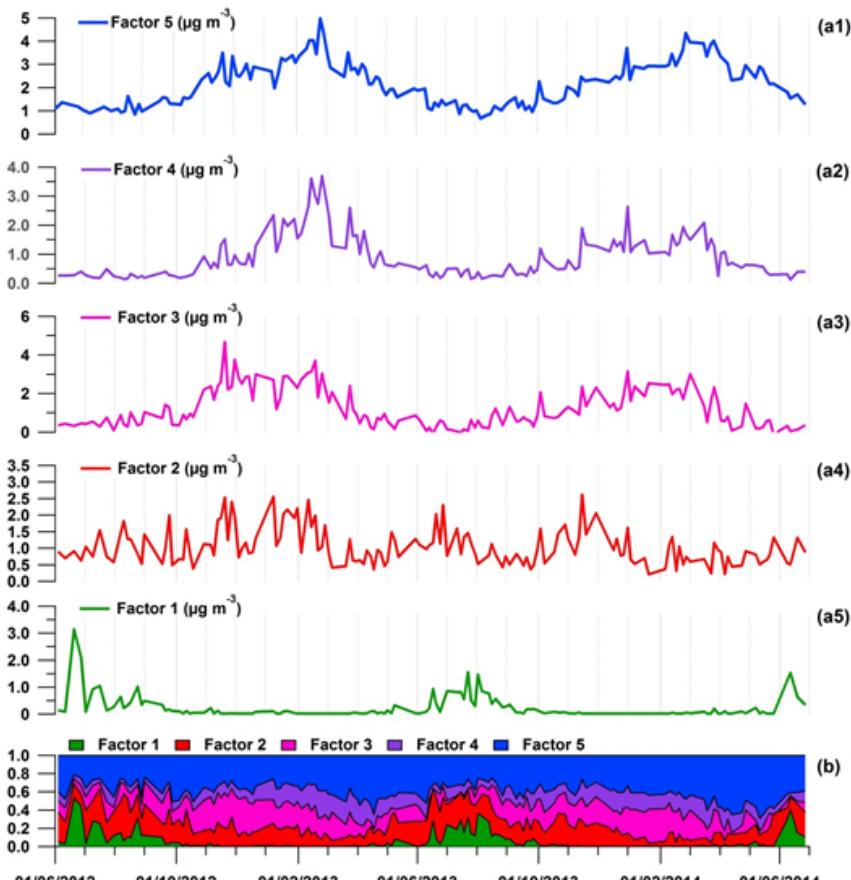
Figure 8. (a) Time series of factor contributions (µgm − 3 ) and (b) accumulated relative NMHC contributions. Factor 1 – local biogenic source; factor 2 – short-lived anthropogenic sources; factor 3 – evaporative sources; factor 4 – long-lived combustion sources; factor 5 – regional background. Note that the NMHC dataset used for the PMF analysis included different sampling time hours (09:00–13:00 or 12:00–16:00UTC) following shifts during the 2-year period (see Table